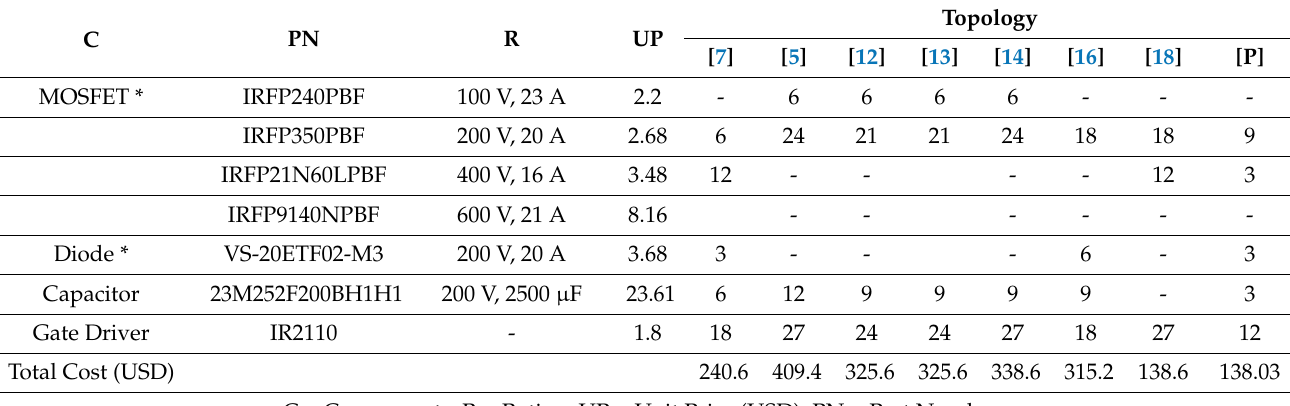
Table 3. Cost analysis of the proposed topology compared with the existing topologies.